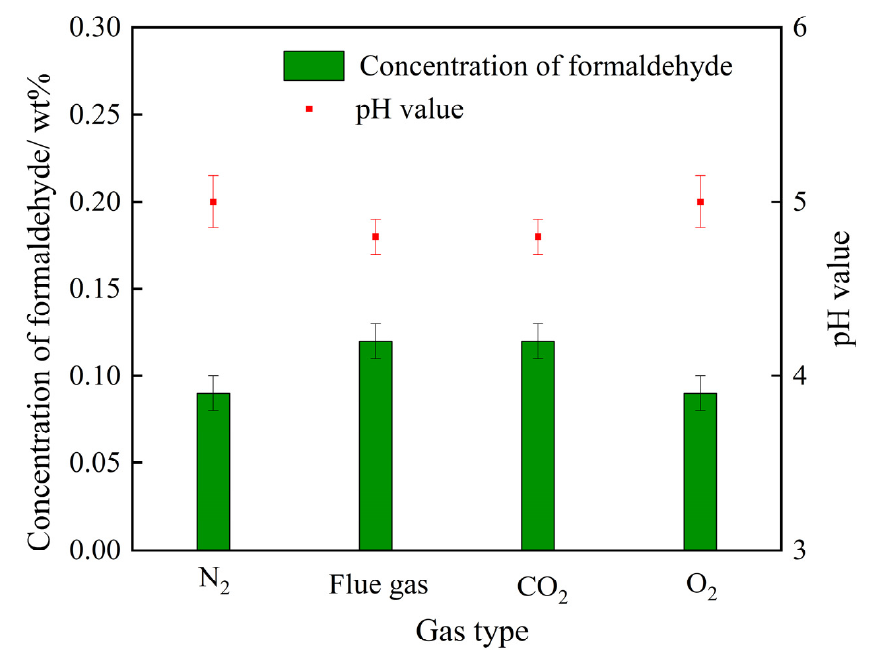
Figure 8. The effect of gas type on the formaldehyde concentration and the pH value of the HMTA solution.